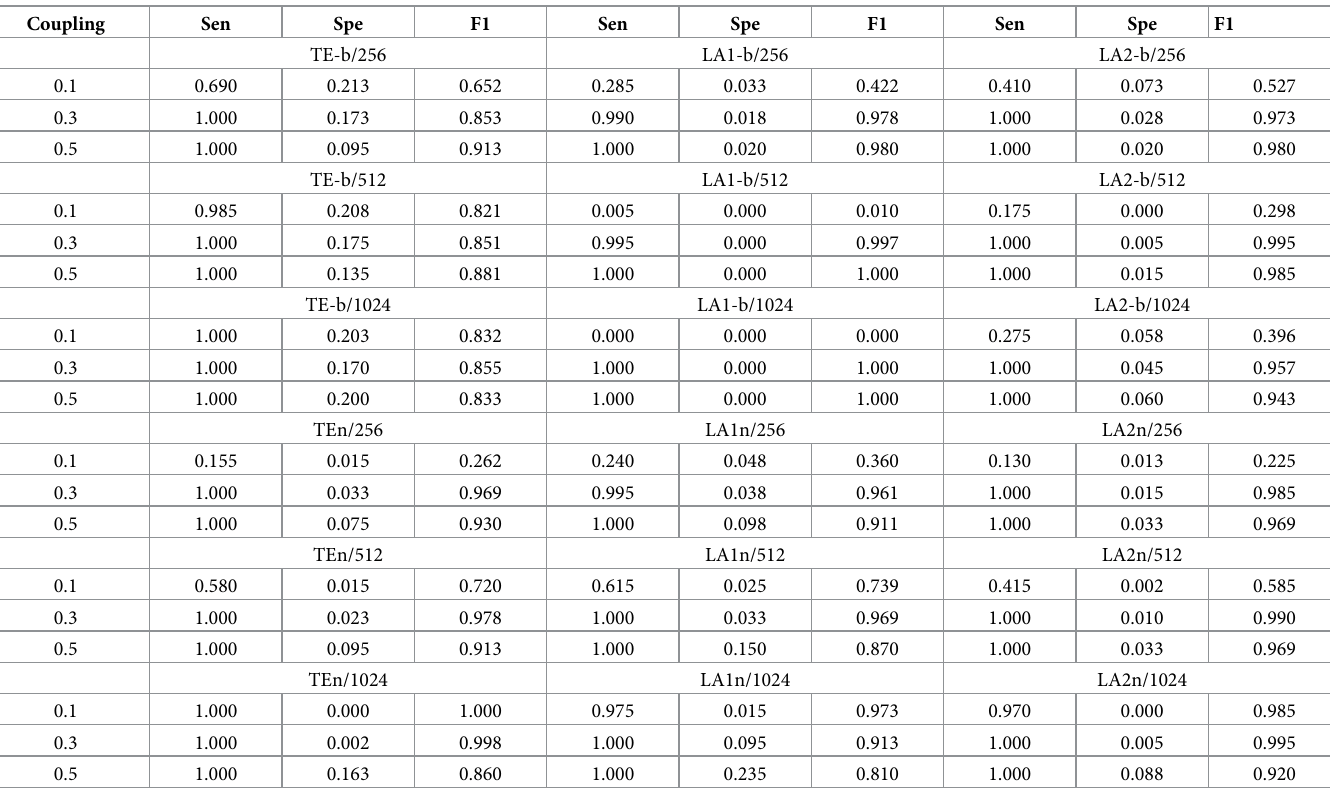
Table 6. Sensitivity, specificity and F1 score values obtained from Model F by binning(-b) and NN(-n) estimators with different data lengths and coupling strengths.